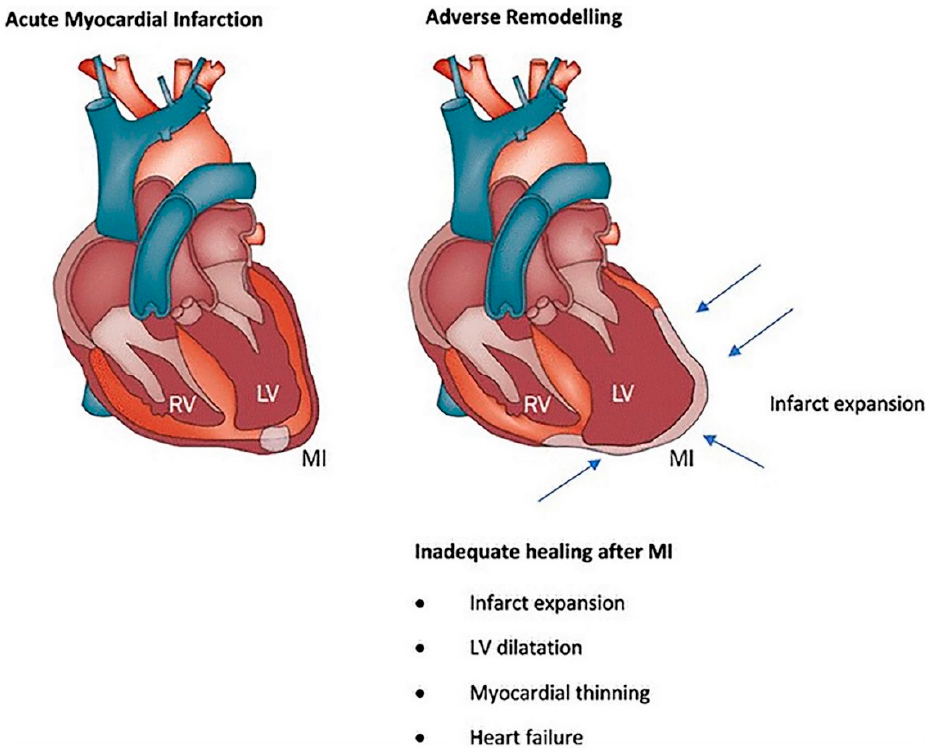
Figure 1. Left ventricular (LV) enlargement in the post-infarction phase due to thinning and dilation of the infarct zone (infarct expansion). Reproduced with permission from Curley et al. [3].